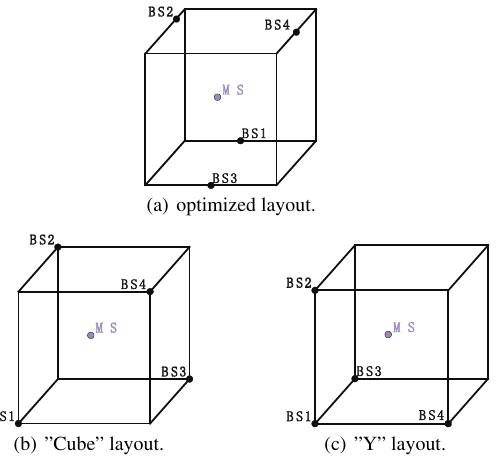
Figure 7. Different layouts of four base stations.